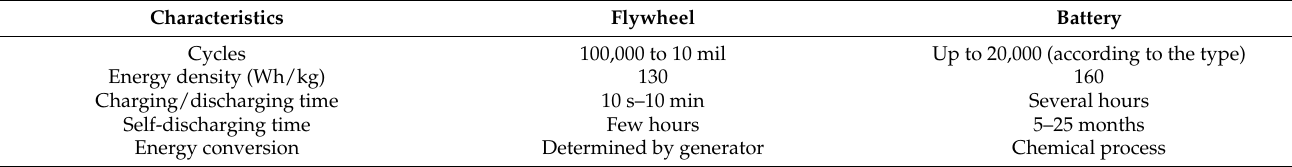
Table 3. Comparison between characteristic performance of flywheel and battery [47,49,51,61–64]. Characteristics